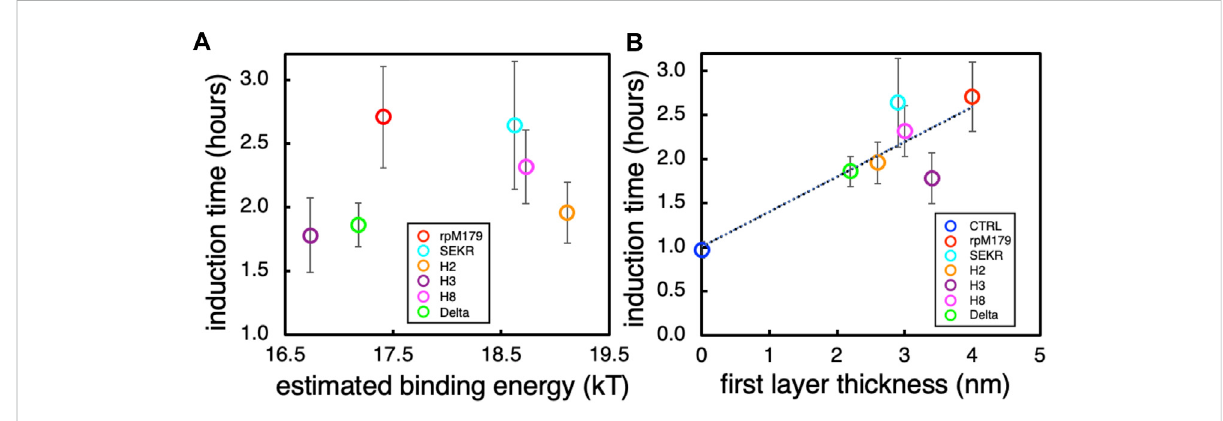
FIGURE 7 (A) The induction time for the ACP to HAP transformation as a function of the estimated binding energies obtained from Supplementary Figure S10. (B) The induction time as a function of the estimated thickness of the fi rst layer of adsorbates obtained from the mean heights of the oligomers from Figure